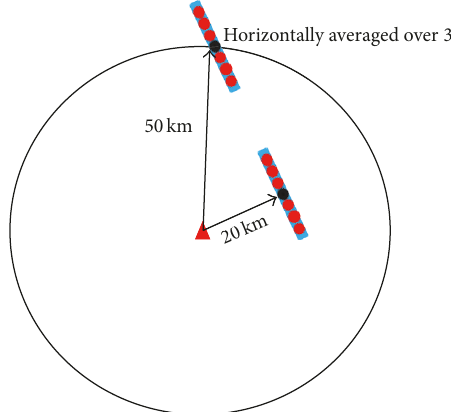
Figure 8: Spatial relationship between ground-based Lidar station and CALIOP footprints during CALIOP overpass. The red triangle represents the position of Lille Lidar station, the red circle represents the footprints of CALIOP, the black circle represents the position of CALIOP footprint at the specified spatial distance (e.g., 20 km and 50 km), and the blue rectangle represents 30km window size of horizontally running mean for the black